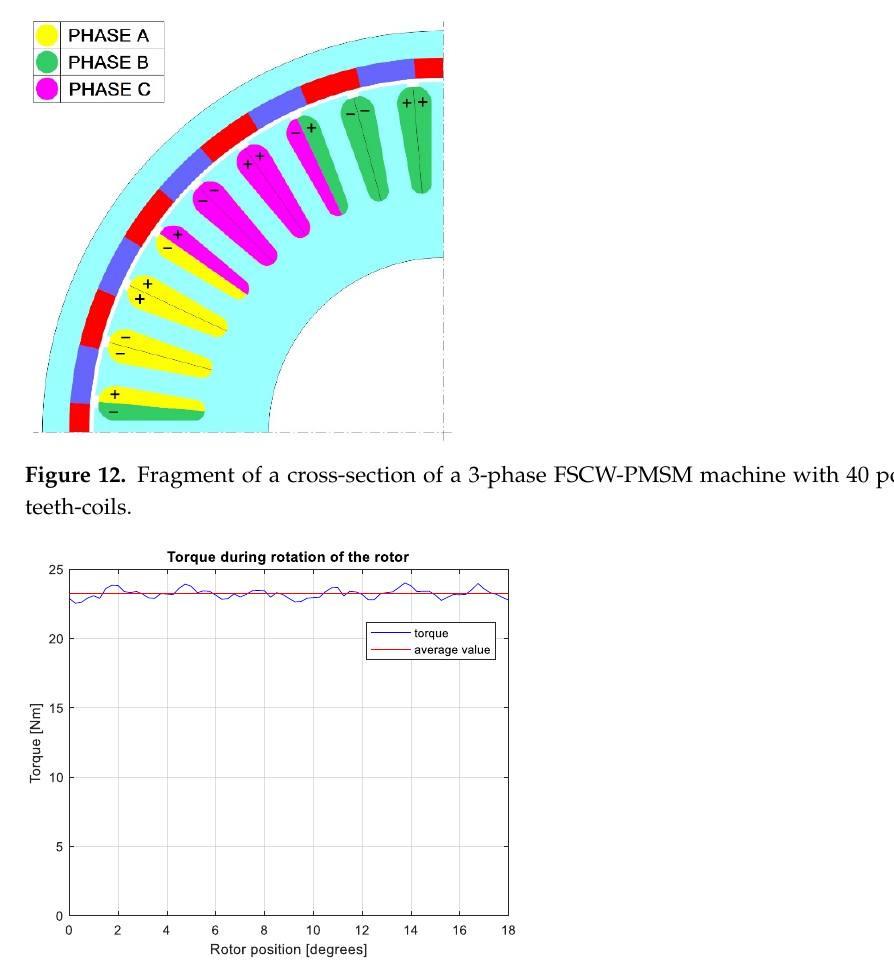
Figure 13. Torque calculations of a Fractional Slot Concentrated Winding—Permanent Magnet Brushless DC (FSCW PMBLDC) machine with 40 poles and 36 teeth-coils considering saturation.